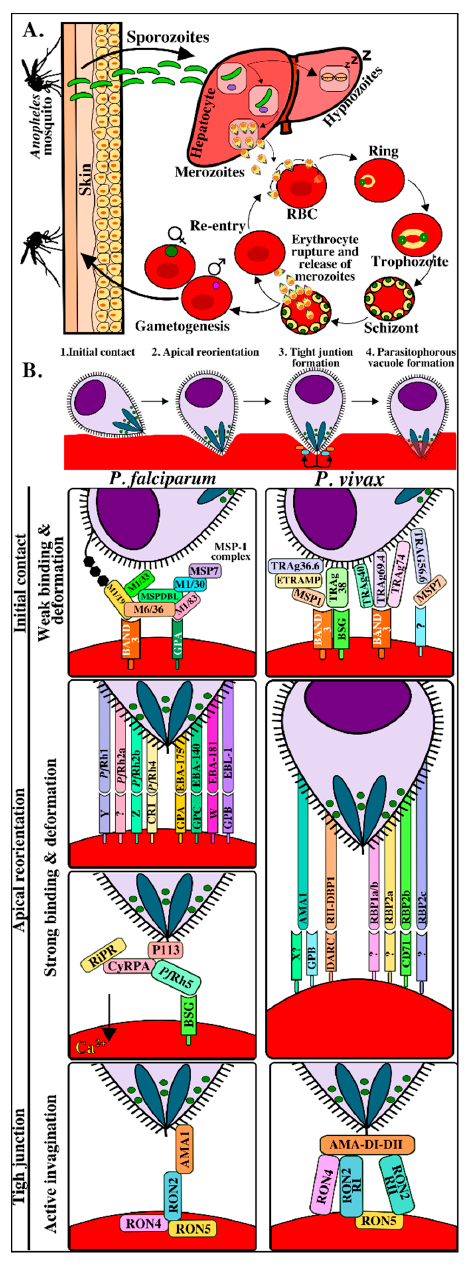
Figure 1. Plasmodium life cycle and erythrocyte invasion interactions. ( A ). The Plasmodium life-cycle has two phases in its hosts: the asexual phase in humans (vertebrates) and the sexual phase in Anopheles mosquitos (invertebrate). Female Anopheles mosquitos’ bites transmit the parasite in its sporozoite form into host dermis [19]. The inoculated sporozoites migrate through the bloodstream until reaching, invading, and developing within the hepatocytes. Some sporozoites may remain in a latent state within the hepatocytes (hypnozoites) during Plasmodium vivax invasion while others become transformed into a new parasite form called merozoite [34]. Once merozoites are released into circulation, they invade new red blood cells (RBC) and some become gametocytes which can be ingested by other mosquitos during a new bite. The parasite begins its sexual cycle in a mosquito to give rise to new sporozoites that will be transmitted to humans thereby starting the asexual cycle again in a vertebrate host. ( B ). Molecular events during Plasmodium merozoite invasion of RBC. Initial contact with target cells, merozoite apical pole reorientation to ensure direct contact with host cell membrane and establishing specific high-a ffi nity interactions, tight junction formation acting as an anchor, and creating the parasitophorous vacuole, following parasite gliding motility towards target cells where they replicate, producing 30–50 new merozoites and subsequently following their cycle to invade